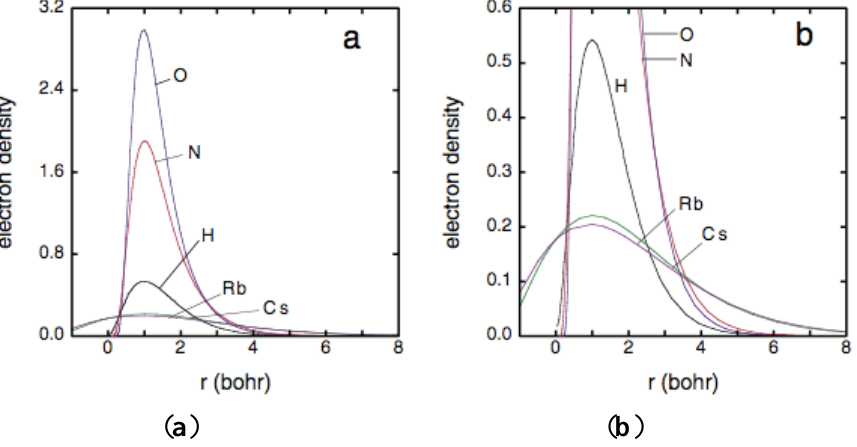
Figure 2. Electron densities (4πr 2 ψ*ψ) plotted versus radii [24,29]. To look at radial extents of outer electrons, for comparison purposes peak of each distribution was shifted to r = 1 bohr in plots. Curves in ( b ) are curves in ( a ) plotted on expanded